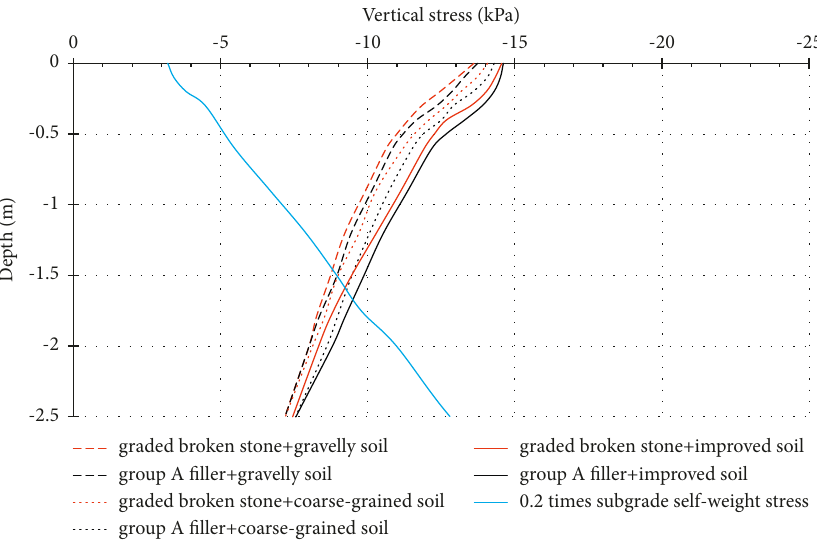
Figure 12: Vertical stress distribution curve of the subgrade bed.